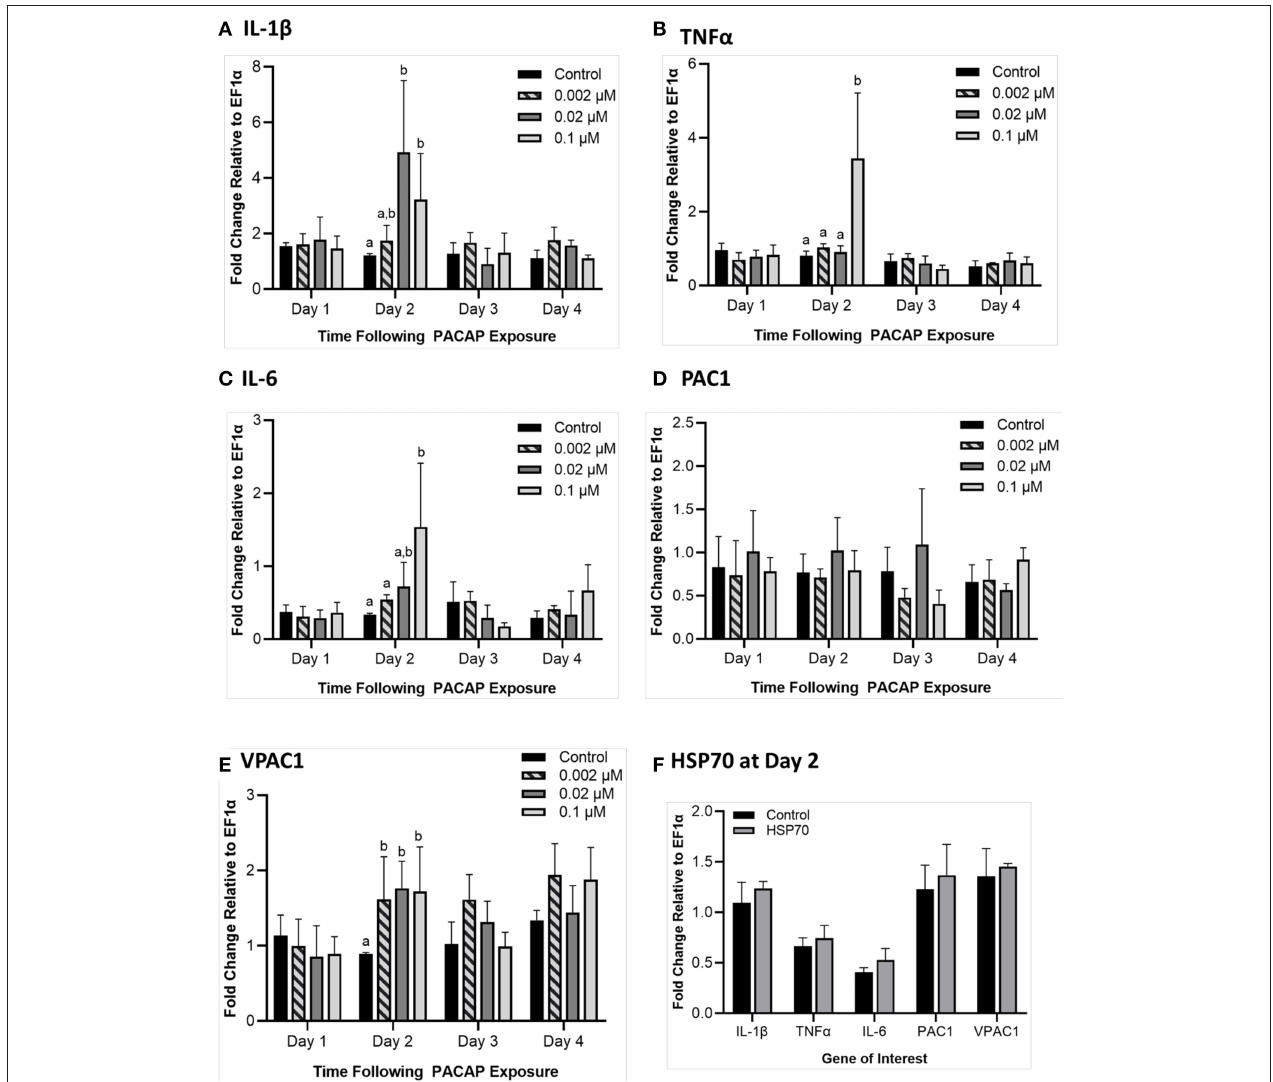
FIGURE 5 | Impact of C. gariepinus PACAP-38 (0.002 µ M, 0.02 µ M and 0.1 µ M) on RTS11 pro-inflammatory cytokines and receptors PAC1 and VPAC1 mRNA expression 1–4 days following peptide exposure. Transcript expression of pro-inflammatory cytokines IL-1 β (A) , TNF α (B) and IL-6 (C) was measured so that the influence of PACAP alone on immune function could be assessed. The present PACAP receptors PAC1 (D) and VPAC1 (E) were also measured to determine whether PACAP could prime RTS11 cells to bind more PACAP. Because 1 day after the pre-exposure appeared to be the only timepoint with significant upregulation due to PACAP, RTS11 was also exposed to 0.1 µ M of a synthetic HSP70 peptide fragment control of comparable size (1.3 kDa), for 48h to confirm that this stimulation was due to PACAP and not a property of synthetic peptides alone (F) . All panels represent three independent experiments and are presented as means + SD. A p < 0.05 was considered to be statistically significant when compared to the no PACAP control for each timepoint. Lowercase letters denote significant differences at p <